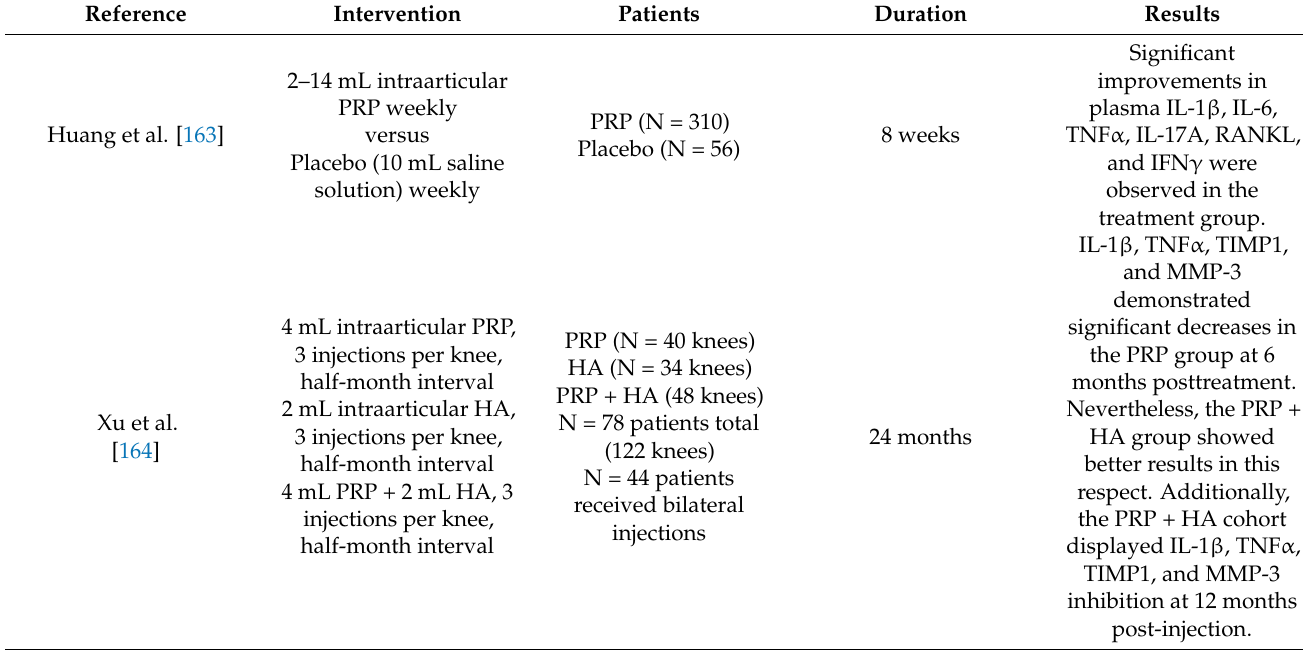
Table 2. Platelet-rich plasma (PRP) treatment in knee OA: anti-inflammatory